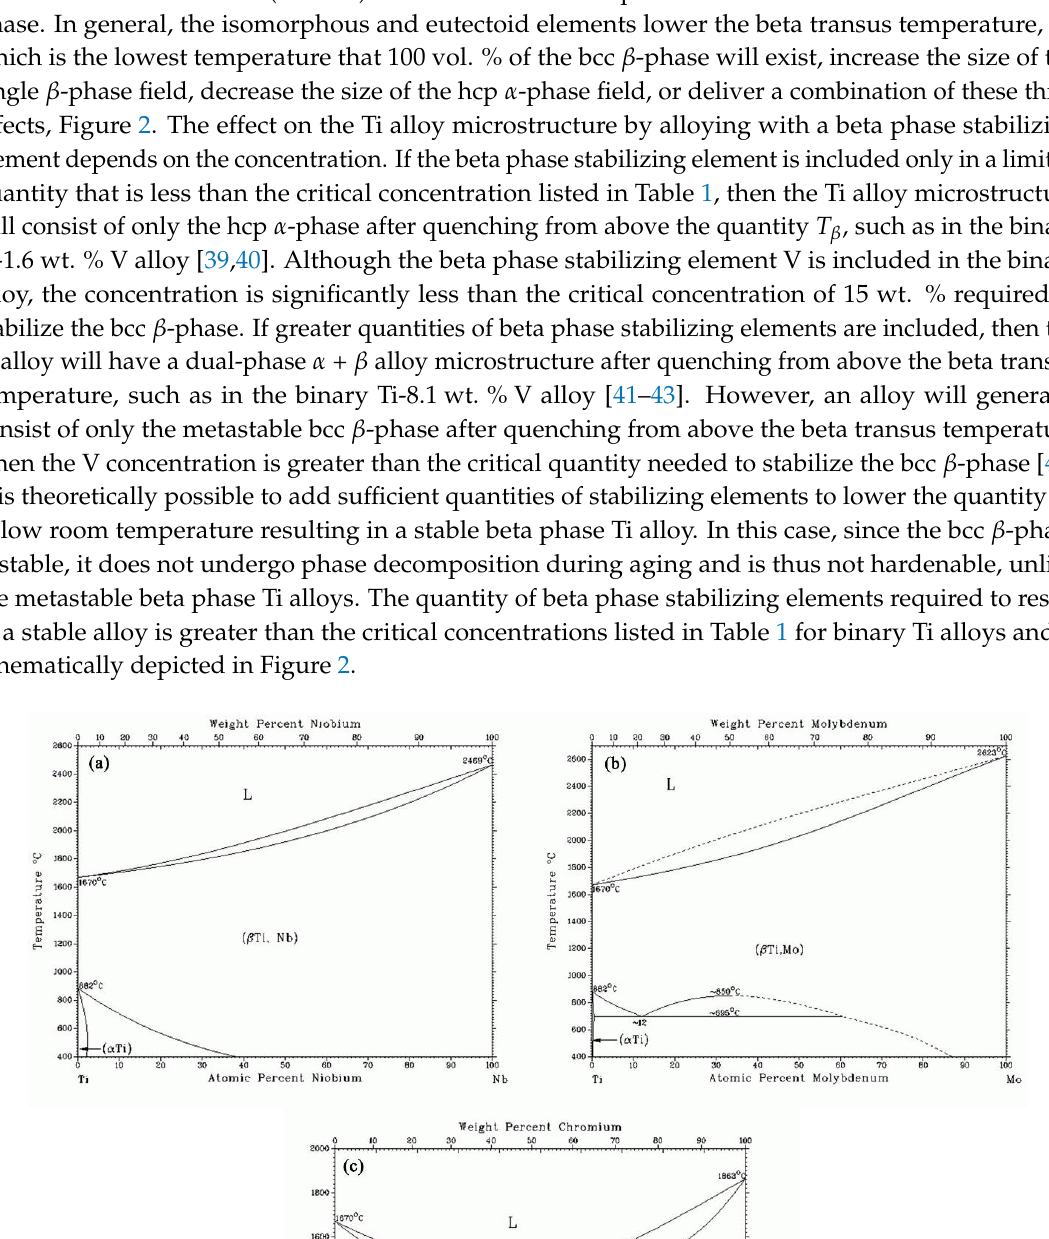
Figure 2. The effect on the Ti alloy microstructure by alloying with a beta phase stabilizing element